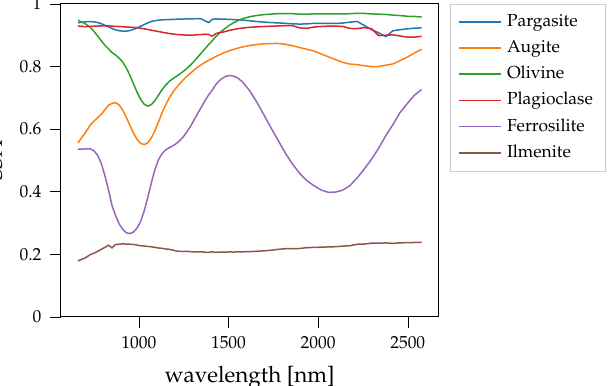
Figure 14. The endmembers for the experiment in Section 3.2 taken from Rommel et al. [13]. PRG: pargasite, AUG: augite, OLV: olivine, PLG: plagioclase (labradorite B), FS: ferrosilite, ILM: hemo-